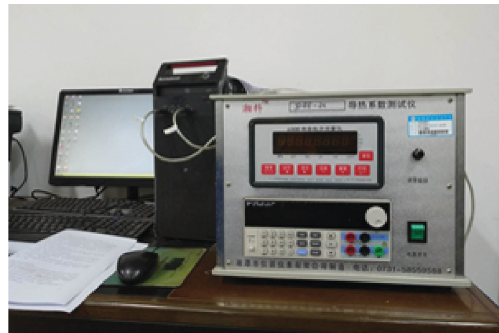
Figure 5: Test of thermal conductivity of soil